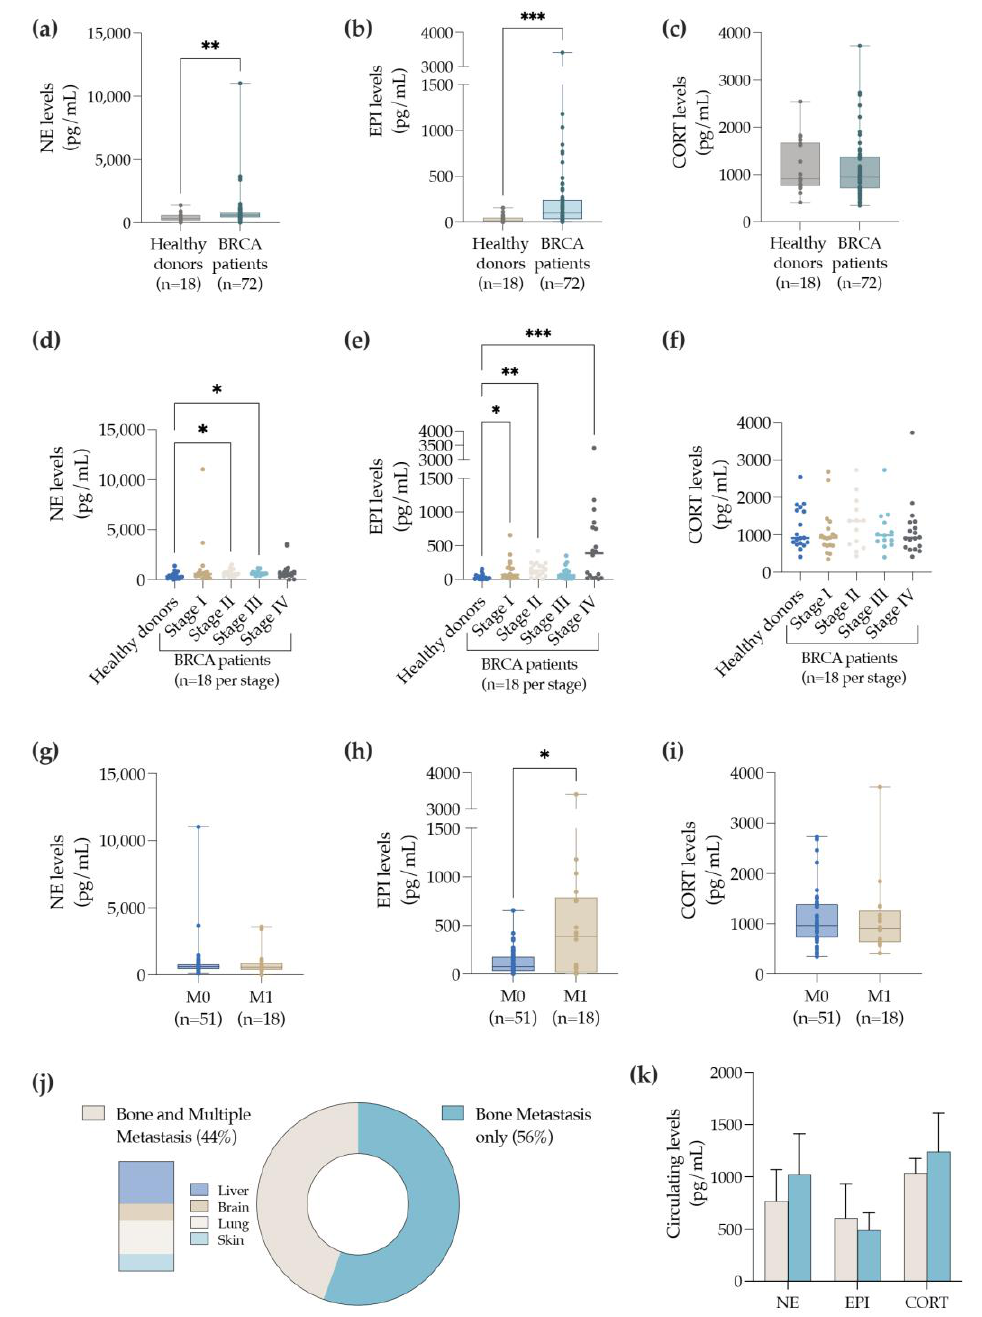
Figure 1. Plasma levels of catecholamines in a cohort of BC patients. Systemic levels of NE ( a ) and EPI ( b ) CORT ( c ) in the BC patients (n = 72) versus healthy donors (n = 18). The circulating levels of NE ( d ), EPI ( e ) and CORT ( f ) at all stages of the disease were discriminated in relation to the healthy donors (n = 18 per stage). Additionally, the systemic levels of NE ( g ), EPI ( h ), and CORT ( i ) in the BC patients displaying no distant metastasis (M0; n = 51) versus the BC patients with distant metastasis (M1; n = 18) were also analyzed. BC patients with distant metastasis exhibiting bone metastasis only (56%) or multiple metastasis sites (44%), namely, in bone, liver, brain, lung, and skin are shown ( j ). The systemic levels of catecholamines, NE and EPI, and CORT were compared between BC patients displaying bone metastasis only versus multiple metastasis sites ( k ). p -value < 0.05 (*); <0.01 (**), <0.001 (***) was considered statistically